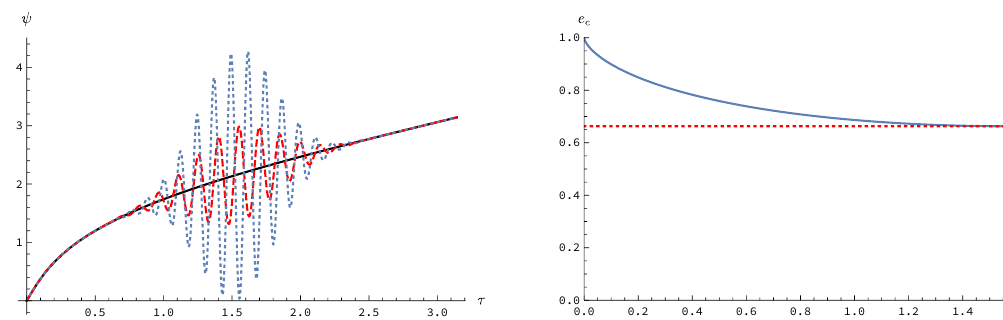
Figure 17 . Left panel: solutions ( (cid:28) ) of Kepler’s equation (C.4) at e = 0 : 75 for (cid:28) 2 [0 ; (cid:25) ] (half a period): \exact" numerical solution of (C.4) (solid black line), series solution (C.5) truncated at 50 terms (dashed red line) and 60 terms (dotted blue line). The rate of convergence is maximal at (cid:28) = (cid:25)= 2. Right panel: the radius of convergence e c ( (cid:28) ) of the series (C.5) as a function of (cid:28) for (cid:28) 2 [0 ; (cid:25)= 2]. The red dotted line coresponds to Laplace’s value e L . For 0 < e < e L , the series converges for all (cid:28) 2 [0 ; 2 (cid:25) ].